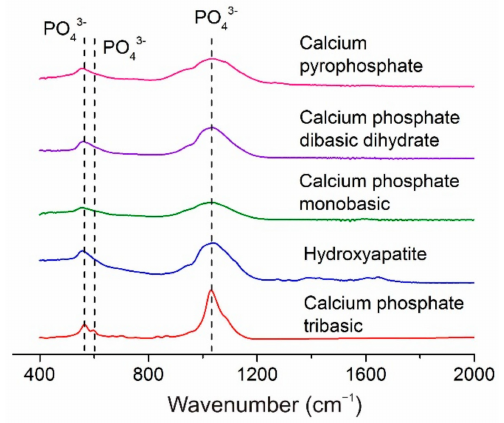
Figure 2. FTIR spectra of the as-deposited Ca-P